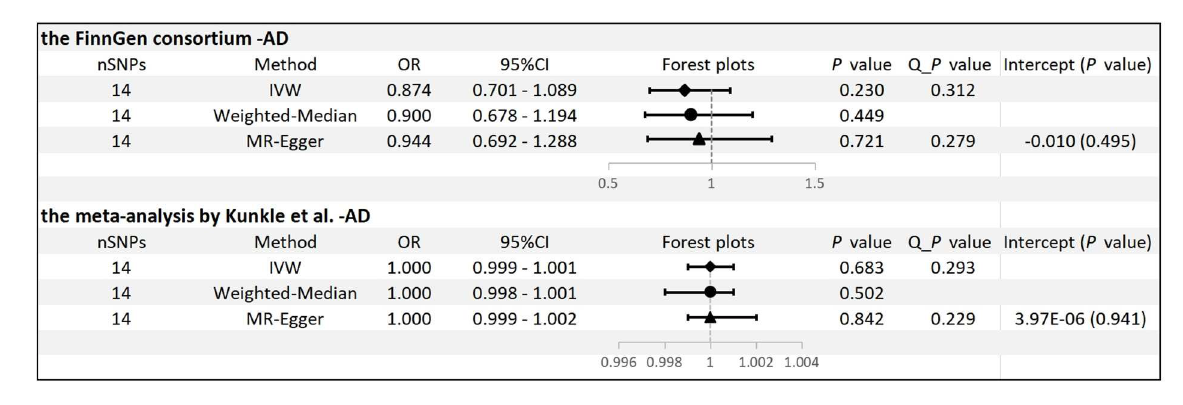
FIGURE2 MR results and sensitivity analysis for association of ADPN and AD. IVW, inverse variance